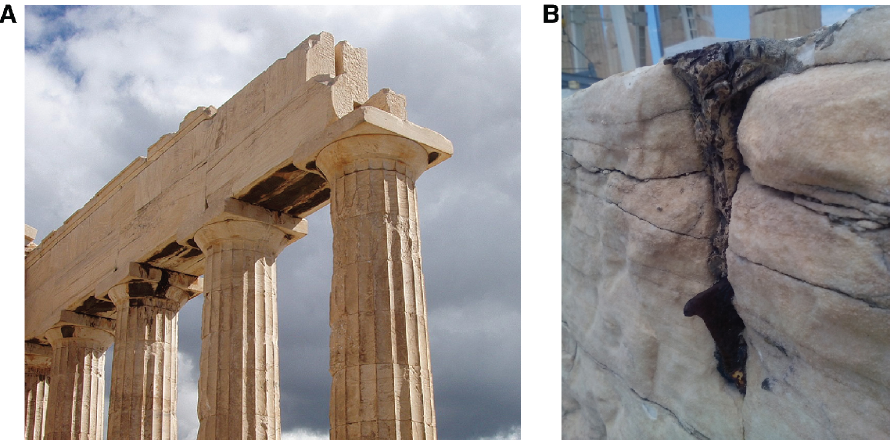
Figure 1: (A) Epistyles of the Parthenon Temple interconnected by means of I-shaped metallic elements. (B) Detailed view of a damaged